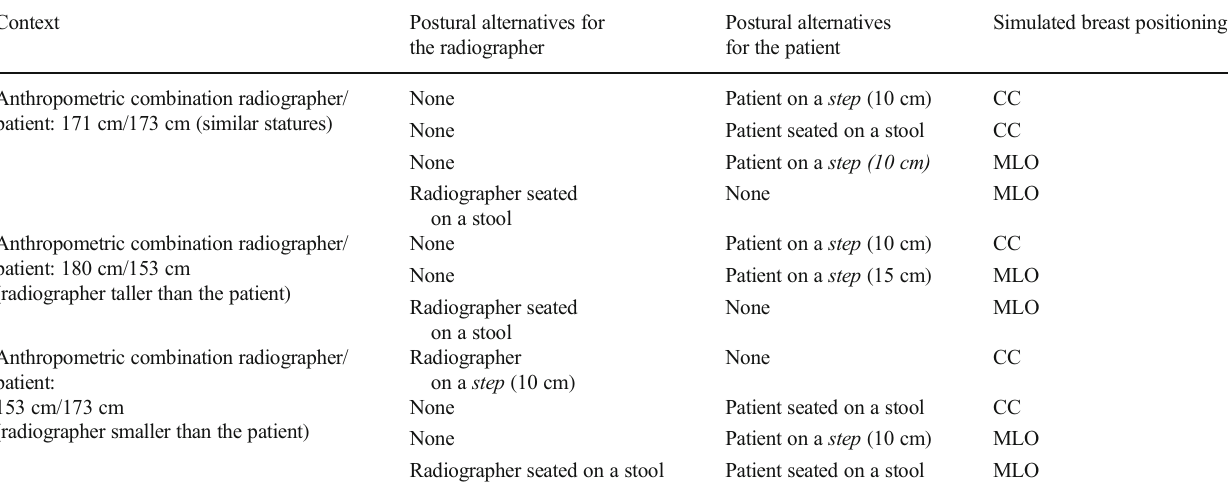
Table2 Simulated contexts during the breastpositioningincraniocaudal(CC) and mediolateral oblique(MLO), withoutand with postural alternatives considering the radiographer and the patient Context Postural alternatives for